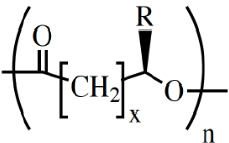
Figure 1. General chemical structure of the PHAs. Typical values: x = 1 to 4; n = 1000 to 10,000; R = alkyl group (C m H 2m+1 ) or functionalized alkyl group. Reused from [37] with kind permission of John Wiley and